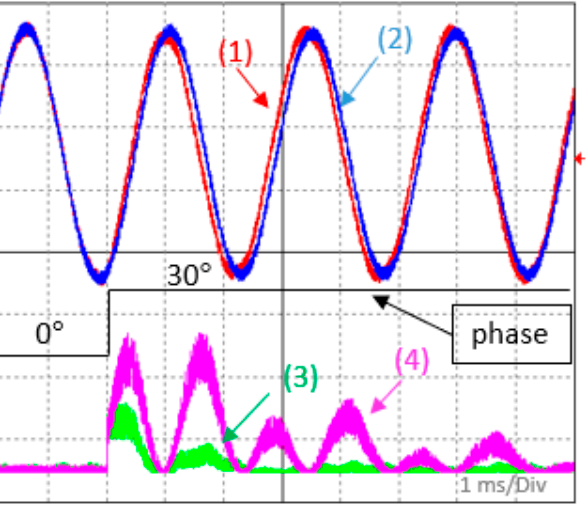
Figure 13. Dynamic performance of the proposed method compared to the EPLL method for phase jump of 30%: (1) estimated fundamental waveform for the FLC method, (2) estimated fundamental waveform for the EPLL, (3) estimation error for the proposed method and (4) estimation error for the EPLL.